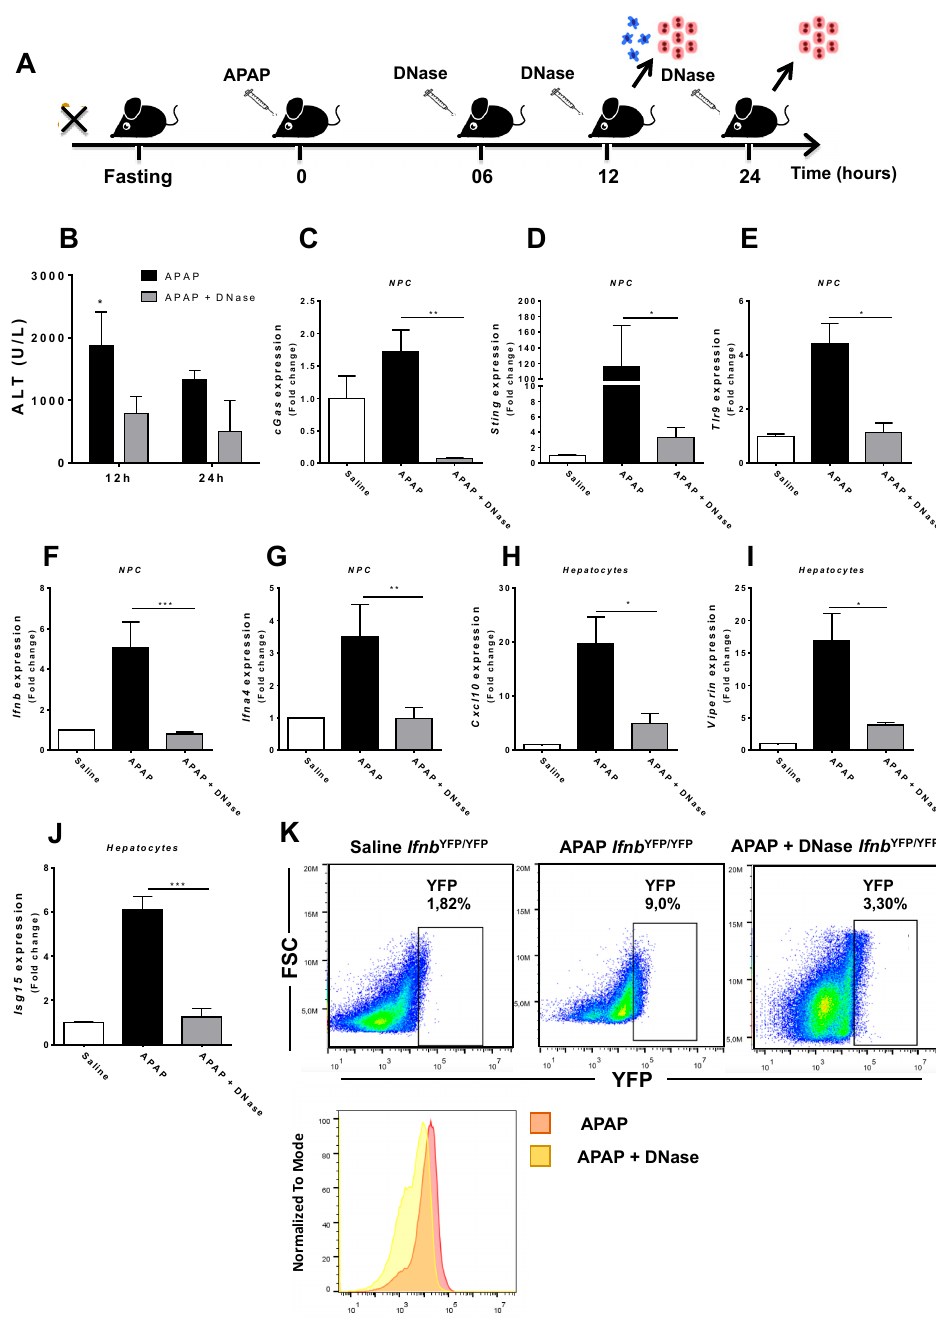
Figure 6. DNase treatment after hepatic injury induction. ( A ) Scheme showing APAP treatment time points (600 mg/kg) and DNase (1000 U/L) in mice over time. ( B ) ALT serum levels to assess hepatic injury at 12 and 24 h after DNase treatment. ( C – G ) Gene expression of different sensors in hepatic non-parenchymal cells between treated and non-treated groups with DNase. Cells were collected 12 h after administration of APAP (600 mg/kg) and relative expression was done using control NPCs (saline) as a reference. ( H – K ) Gene expression of different sensors in hepatocytes between DNase-treated and non-treated groups. ( K ) Flow cytometry to evaluate IFN-I production by non-parenchymal liver cells in DNase-treated and untreated groups. Cells were collected from IFN YFP/YFP mice 12 h after administration of APAP (600 mg/kg). (Mean ± SEM; n = 4); * p ≤ 0.05, ** p ≤ 0.01 and *** p ≤ 0.001. The relative gene expression was done using saline hepatocytes as a